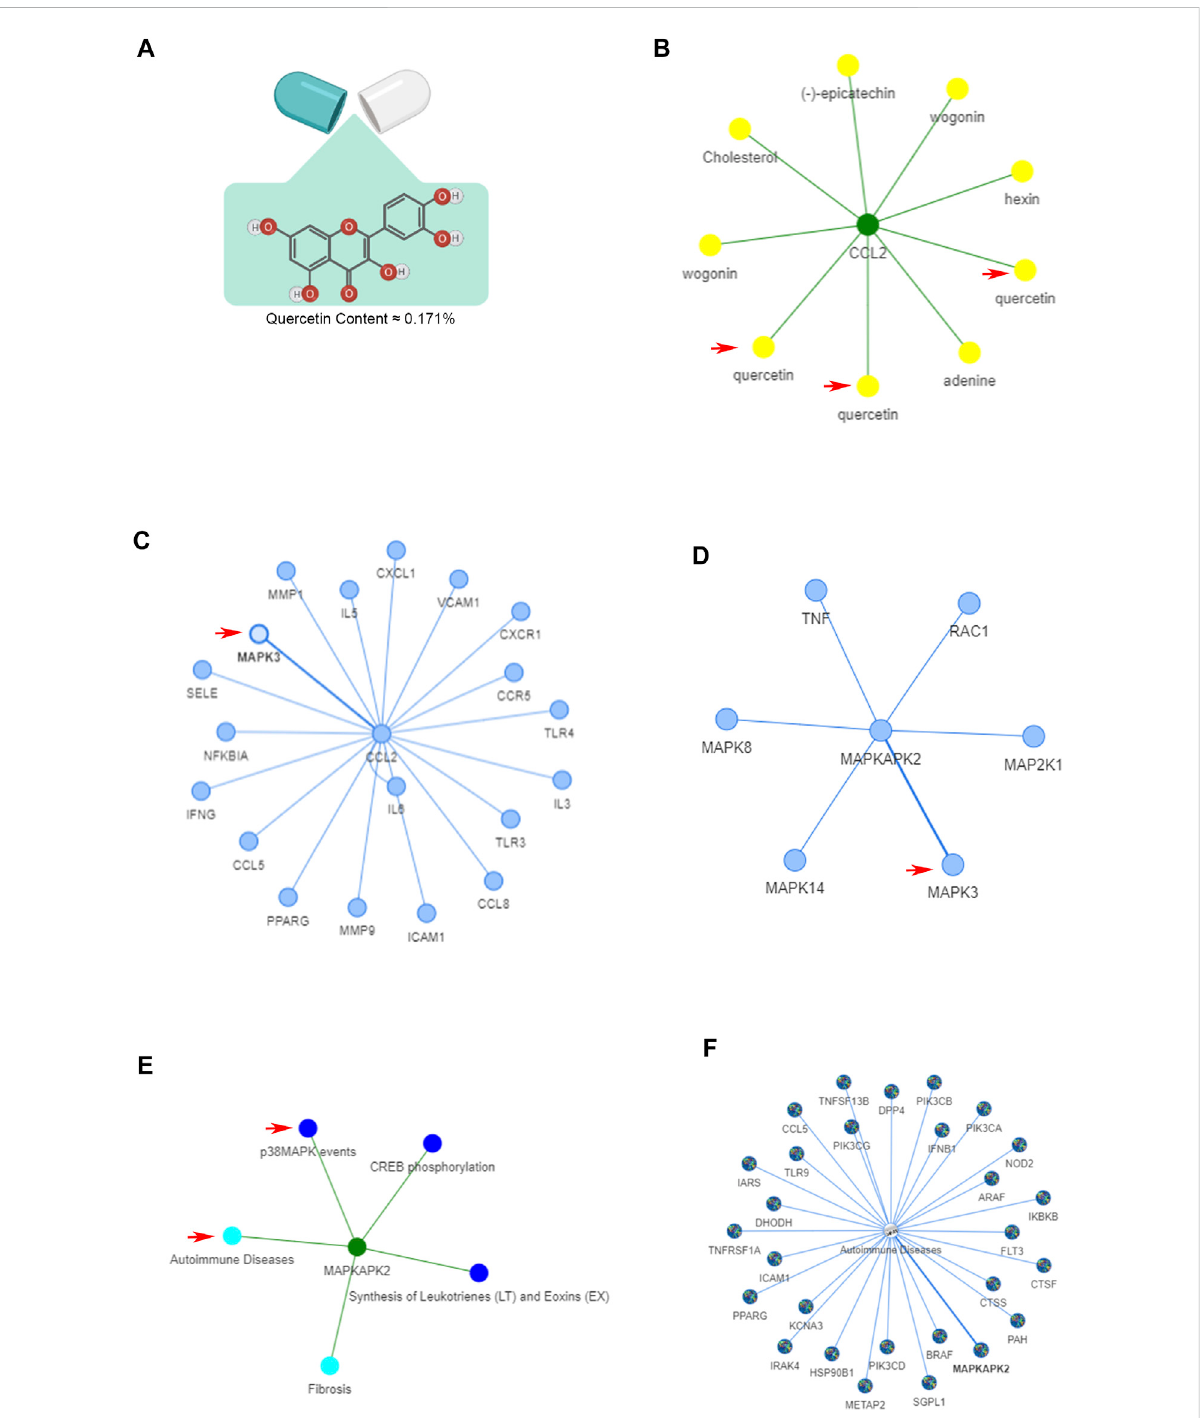
FIGURE 1 Bioinformatics analysis of quercetin (the main ingredient of Ningmitai capsules) in ETCM and TCMIP databases. (A) Structural formula and content of quercetin in Ningmitai capsules. (B) Target – ingredient interaction of CCL2 and quercetin in the ETCM database. (C) Protein ‒ protein interactionoftheCCL2genewithothergenes. (D) MAPKprotein ‒ proteininteractions. (E) Target – pathway – diseaseinteractionoftheMAPKpathway with autoimmune diseases. (F) Pathway – disease interaction of the MAPK pathway with autoimmune